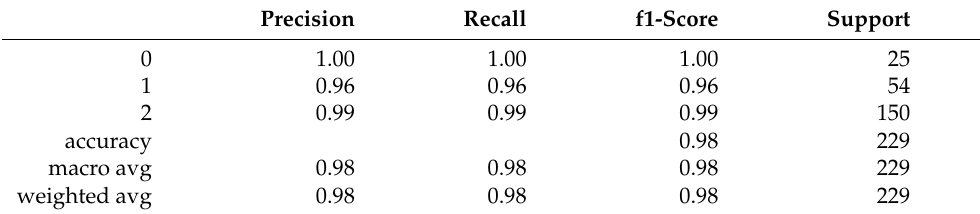
Table 10. KNN metrics on test-set.